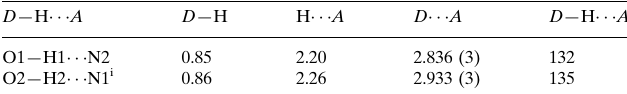
Hydrogen-bond geometry (A˚ , (cid:2)